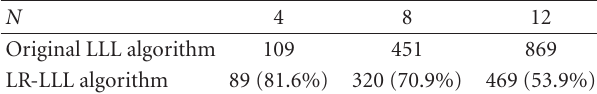
using di ff erent lattice-reduction algorithms. Table 5: Average Cycle of Lattice Reduction Algorithms for dif- ferent antenna